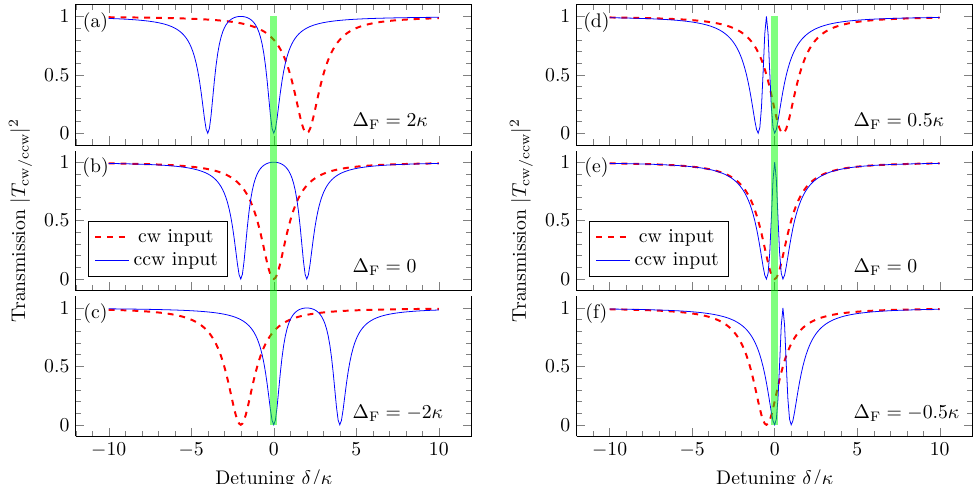
2 of the optical input field versus the T cw,ccw | |